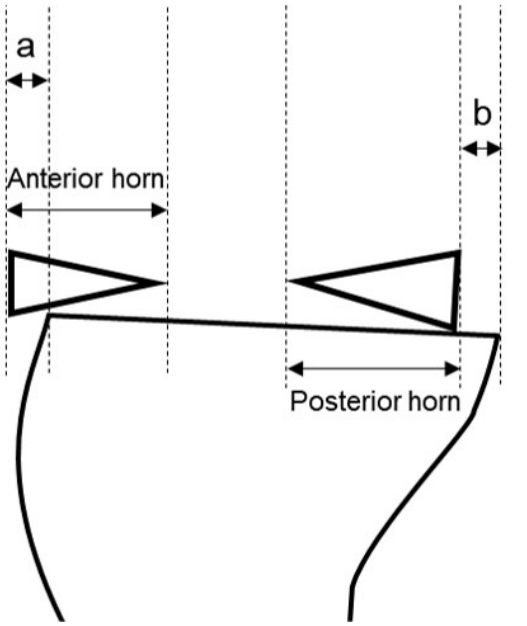
Figure 7. The absolute sagittal anterior horn extrusion ( a ) and posterior horn extrusion ( b ).